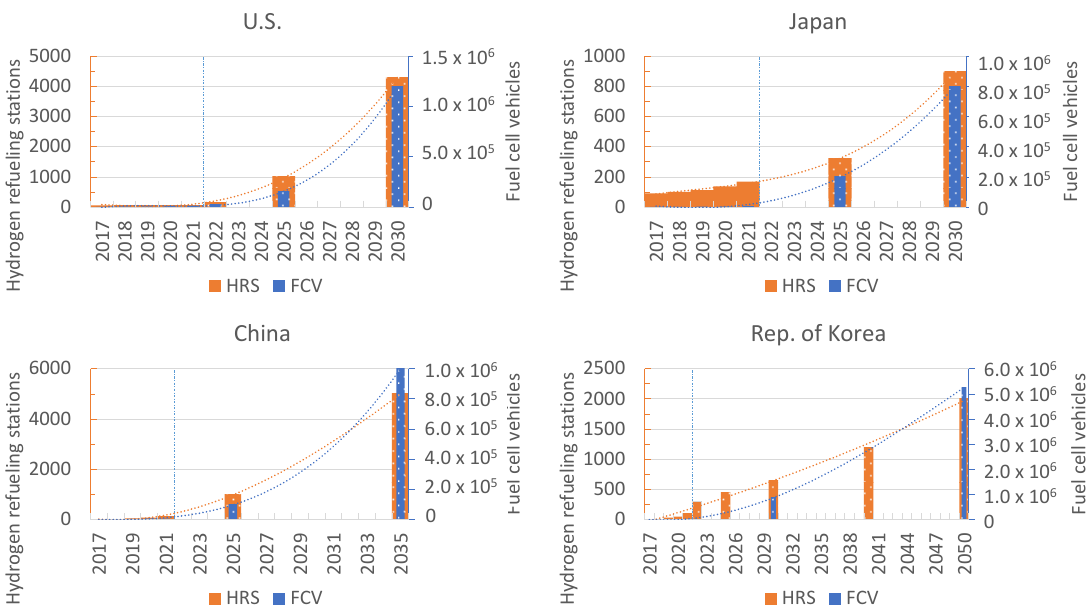
Figure 18. Combination of realized (2017–2021, sources: [6,23–25] and this work) and targeted [113,114,117,118] numbers of FCVs on the road and HRSs in operation for the countries with presently the highest number of FCVs on their roads. To understand the dynamics of the trends, the resulting annual increase rates will be analyzed in the next step. The analysis of the annual increase rates for the development of the vehicle numbers reveals that the highest increase is seen in the first year of the devel- opment prognosis curves. The increase rate is the highest for Japan, with 533%, followed by 296% for South Korea, 209% for China, and 143% for the U.S. in the first prognosis year (2022). For the second year (2023), the increase rate already drops to 32% from 88% and becomes comparable with the values reported in recent years for FCVs. From the third year on, which corresponds to 2024, the Korean annual increase rate drops from 52% over the years to 5% in 2050. For China, the increase rate drops from a comparable value of 55% in 2024 to 18% in 2035, and for Japan from 64% to 25% in 2030. The U.S. exhibits a different behavior here, whereas the first target year is already 2022, as the roadmap was already defined earlier. Here, the increase in the first year was the lowest, as it was defined by the target and not the polynomial function. Therefore, a second strong increase in the annual increase rate is observed for the U.S. in the third year, 2024, and from then on the increase rates drop to 37% in the last target year of 2030. As discussed earlier, a strong increase in the annual increase rate brings the stock to a higher level and further high increases in the absolute numbers are not necessarily ac- companied by a high increase rate. For example, in the case of the highest increase rate in 2022 in Japan, with 533%, the stock increases by 35,900 vehicles in one year. In the follow- ing year, where the annual increase rate corresponds to 88%, the absolute increase is even higher, with 37,400 new vehicles. With this, it is clear that the number of new vehicles introduced increases every year, due to the polynomic function, despite the decreasing annual increase rates. A snapshot for 2030 for each country shows 80,000 new vehicles for China, 141,000 for Korea, 162,000 for Japan, and 322,000 for the U.S. There are a few ex- ceptions to this trend. One is caused by the second strong increase for the U.S. in 2024, the other being for a slight reduction in the absolute stock increase in 2023 for South Korea,